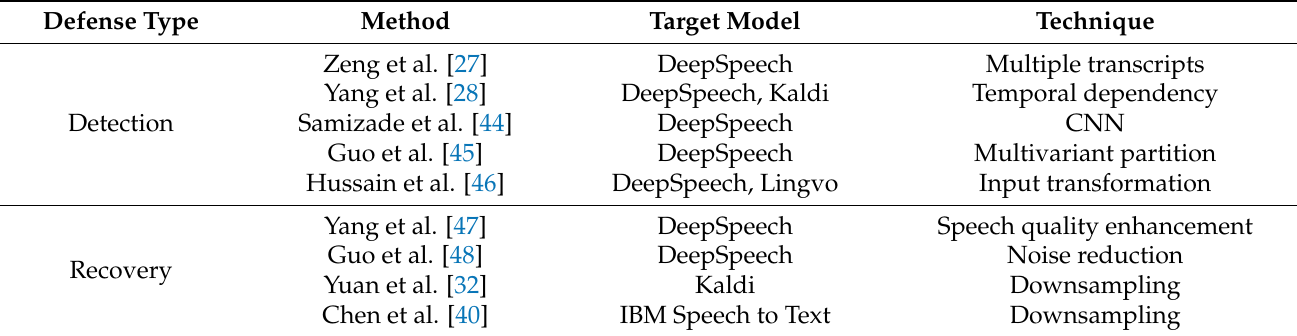
Table 2. Techniques for defending against audio AEs in ASR